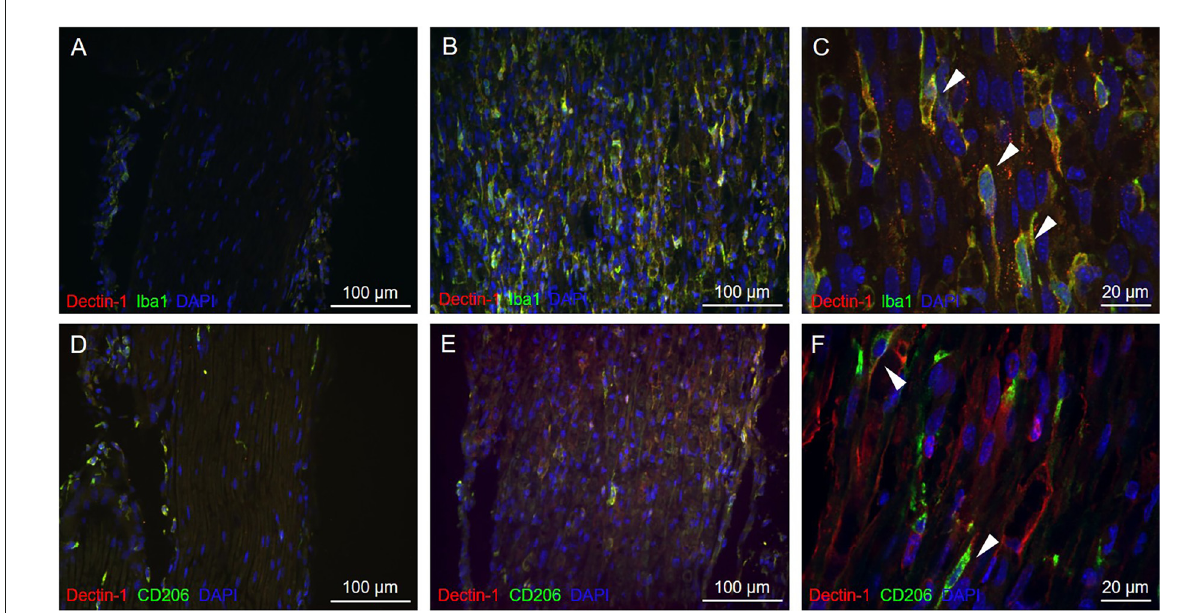
FIGURE3 Immunofluorescence double staining of Dectin-1 and macrophage markers of the contralateral and crushed side. Longitudinal sections from the contralateral (A) and crushed (B,C) sciatic nerve 7 days after crushing injury were immunostained with anti-Dectin-1 antibody (Cy3) and anti-Iba1 antibody (Alexa Fluor 488); longitudinal sections from the contralateral (D) and crushed (E,F) sciatic nerve 7 days after crushing injury were immunostained with anti-Dectin-1 antibody (Cy3) and anti-CD206 antibody (Alexa Fluor 488). (C) Higher resolution images in 630 × showed the presence of Dectin-1(+) macrophages (arrows). (F) Higher resolution images in 630 × showed the presence of Dectin-1(+) M2 macrophages